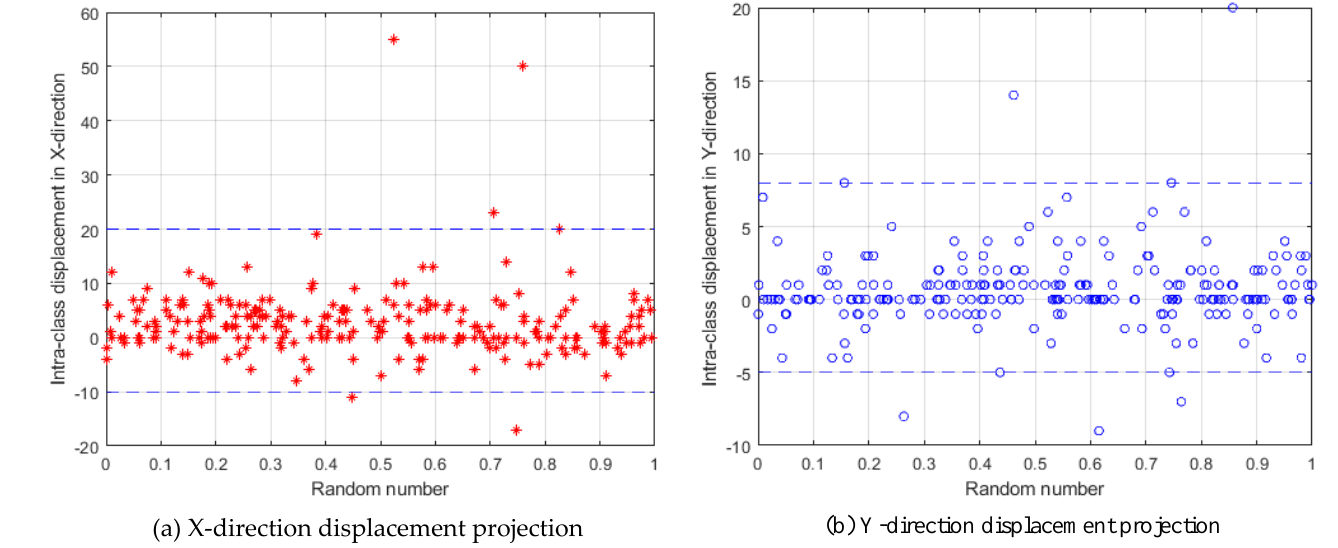
Figure 8. Displacement projection in different